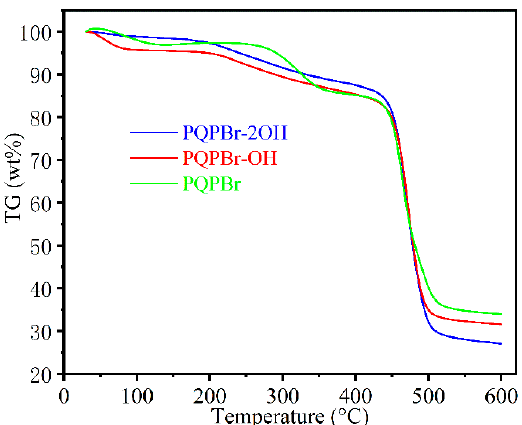
Figure 6. Thermogravimetric analysis (TGA) curves of PQPBr, PQPBr ‐ OH, and PQPBr ‐ 2OH.